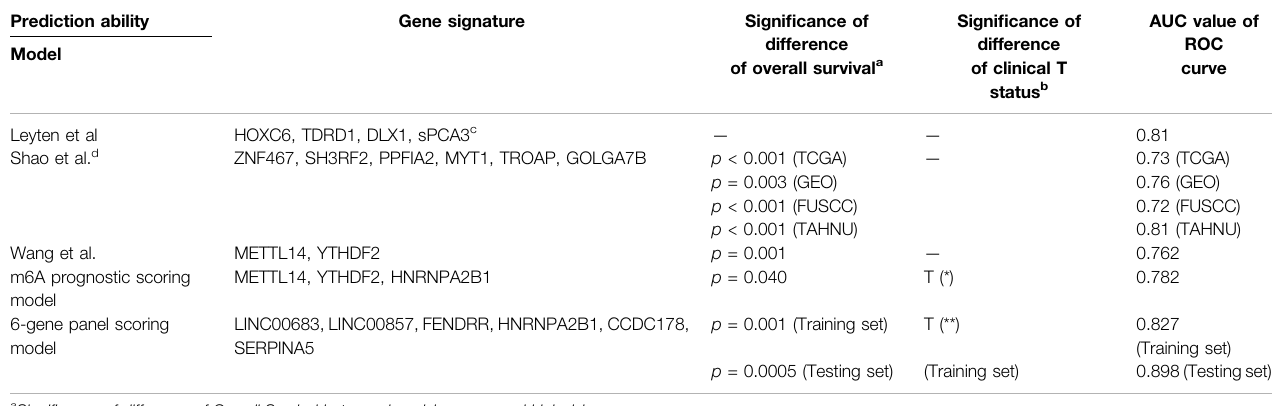
TABLE 1 | Comparison of prediction performance between our scoring model and the previous established model. Prediction ability